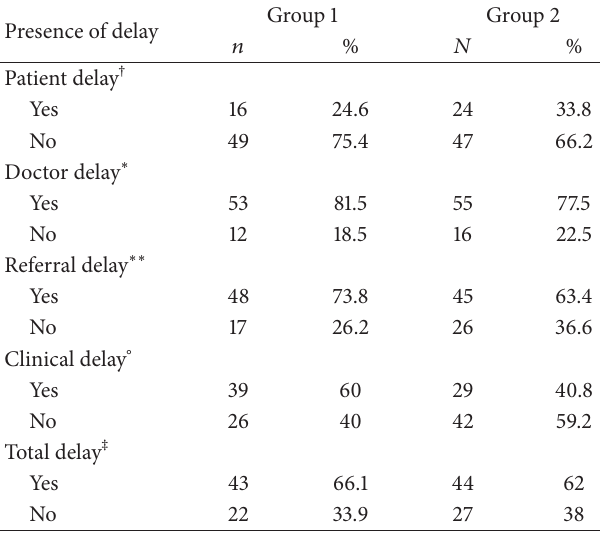
Table 3: Distribution of the patients having delay with respect to delay criteria in